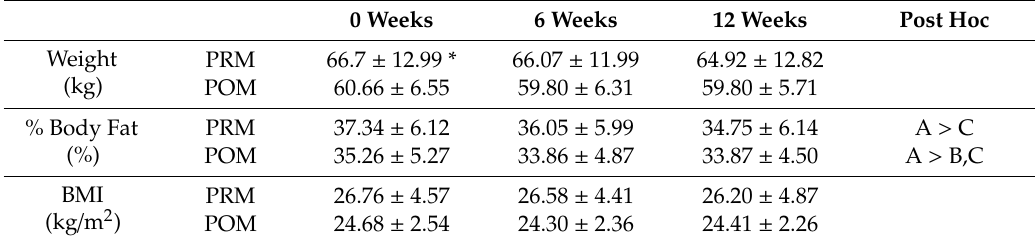
Table 3. Change of body composition after exercise